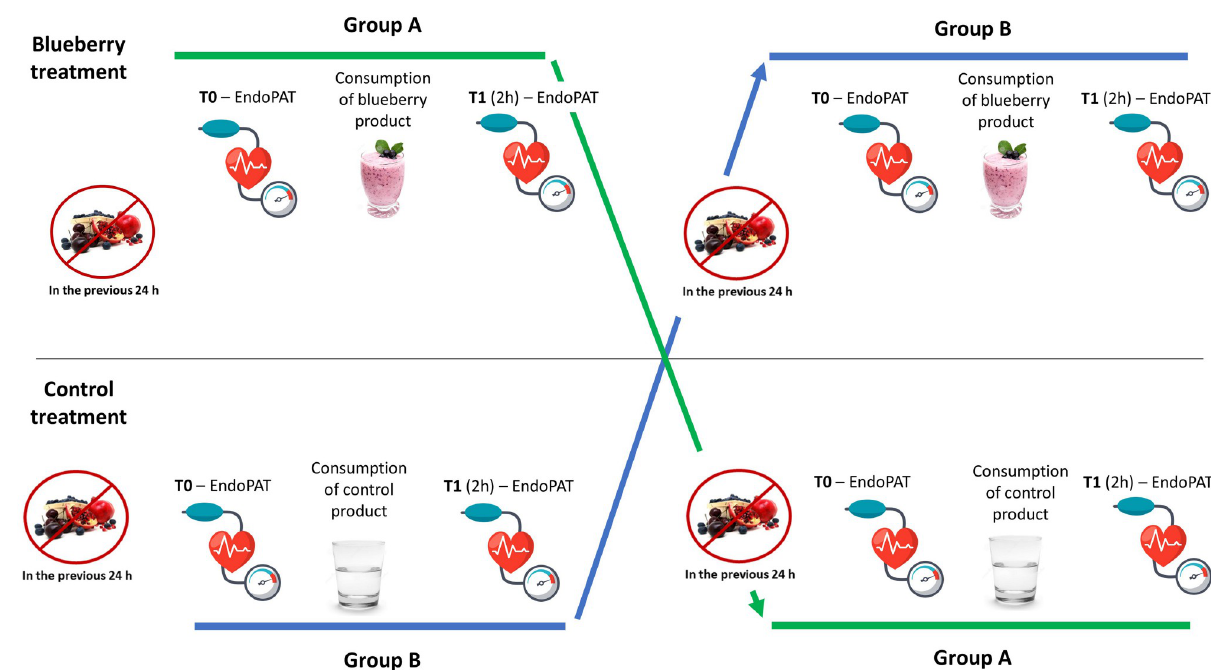
Fig 3. Schematic representation of the study design for the evaluation of the effects of intervention on vascular function markers (phase 2).